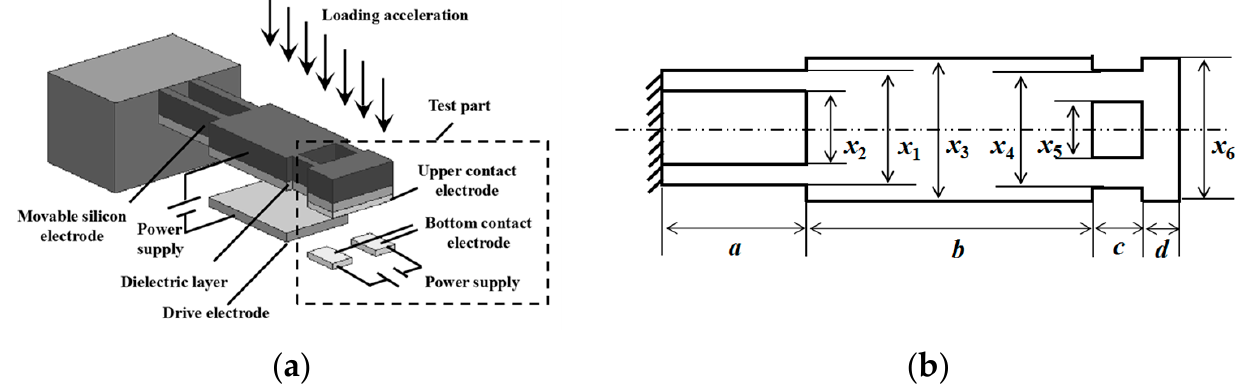
Figure 1. Inertial Micro-switch. ( a ) Switch model with loading acceleration and test circuits. ( b ) Two dimensional structure.